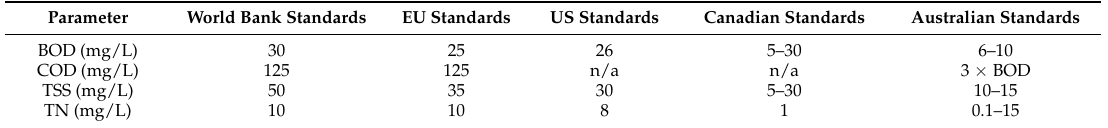
Table 8. The standard limits of common meat processing wastewater effluent set be different jurisdictions worldwide